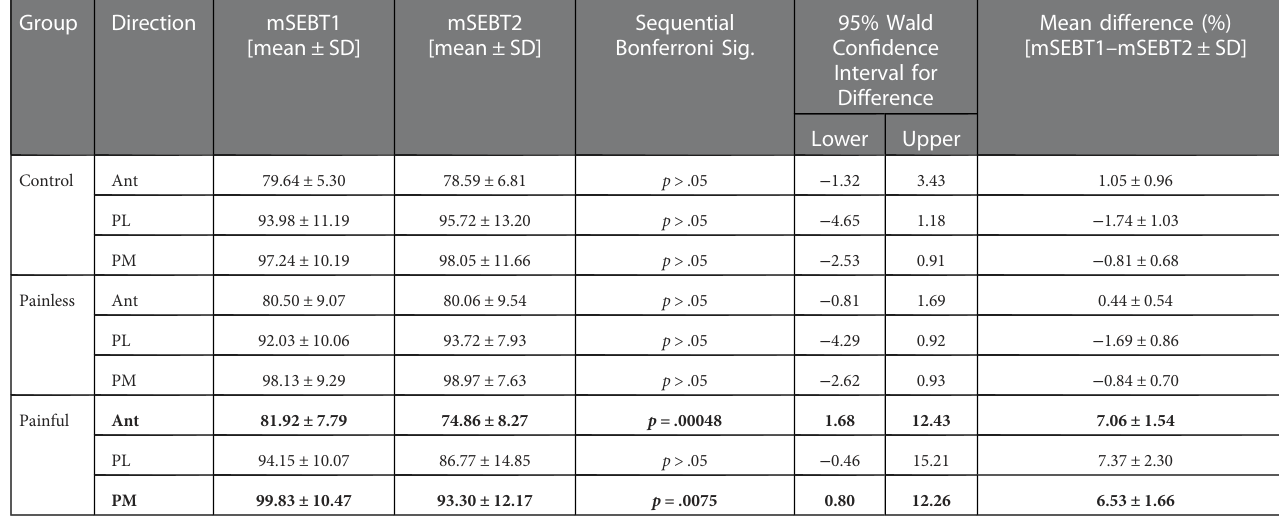
TABLE 2 Post-hoc test results for normalized reach distance.